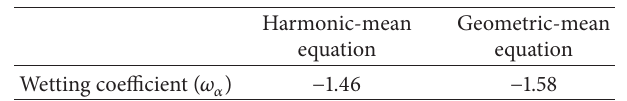
Harmonic-mean Geometric-mean equation equation